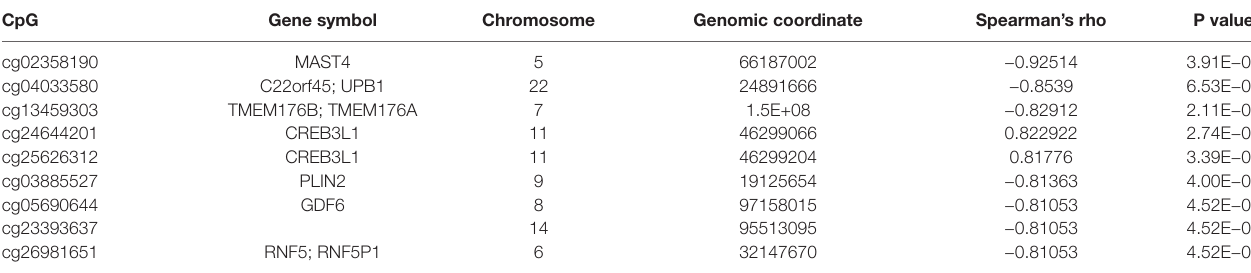
TABLE 2 | List of the top 10 ORR-associated CpGs. CpG